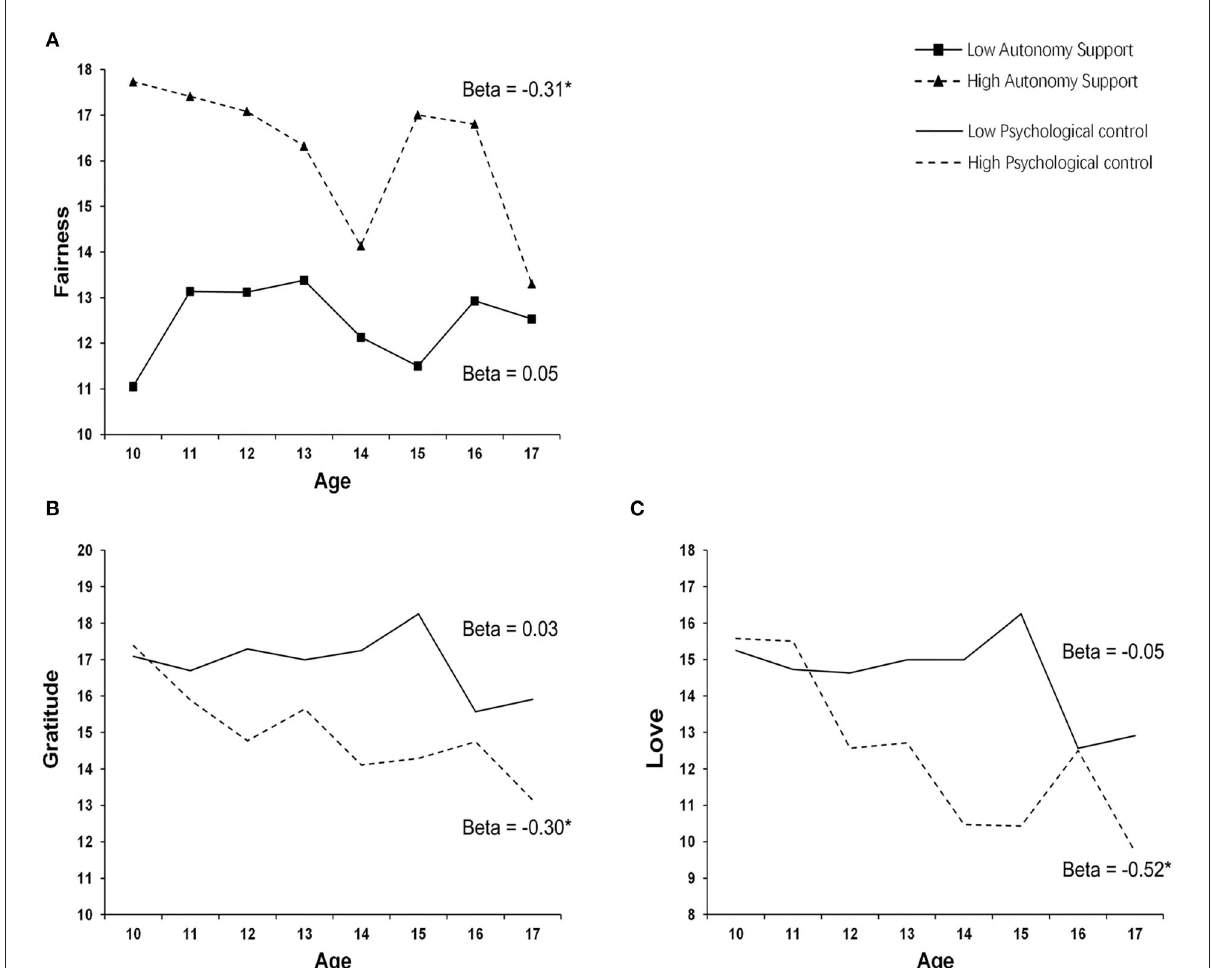
FIGURE3 Results of moderation analyses. Parental autonomy support has a significant effect on age-CSs associations in fairness (A) . Psychological control has a significant effect on age-CSs associations in gratitude (B) and love (C) .